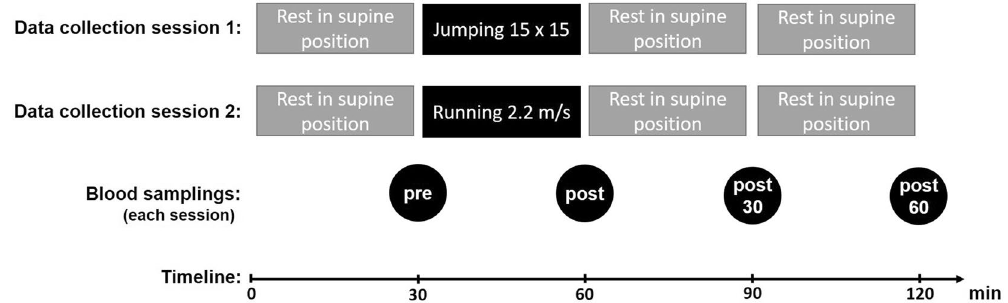
Figure 1. Study design of the two data collection sessions. The first data collection session included a 30 min jump exercise, and the second data collection session included 30 min of running. Both sessions were scheduled equally with four blood samplings every 30 min (“pre” directly before the exercise, “post” immediately after the exercise, “post30” 30 min after the exercise and “post60” 60 min after the